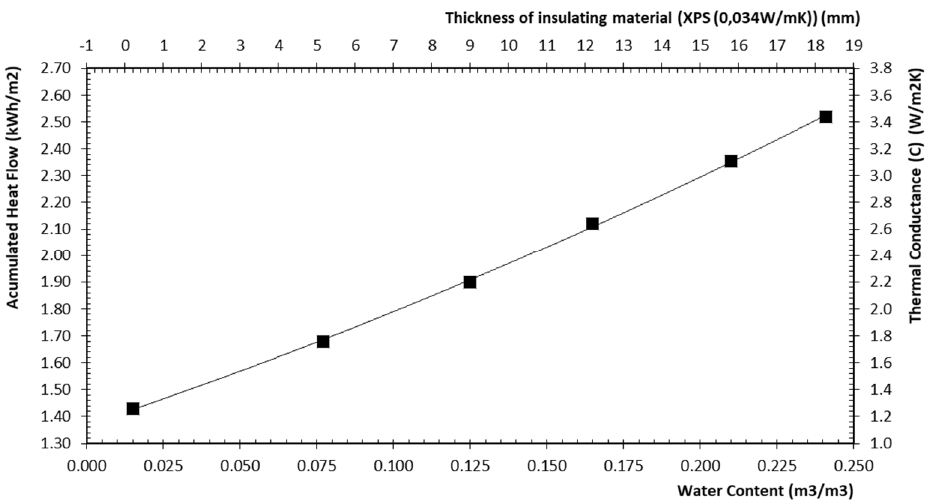
Figure 9. Comparative graph between the water content and the thickness of a leaf of insulating material to match the flow of a dry wall.